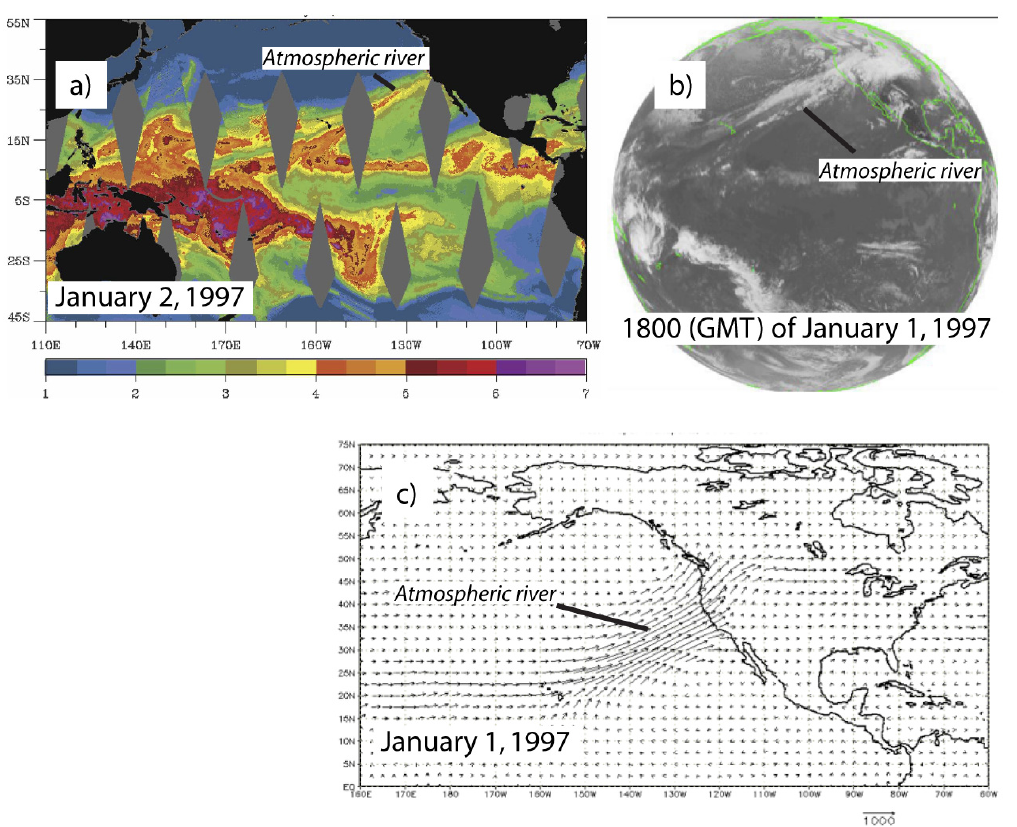
Figure 1. Visualizations of atmospheric-river conditions impacting California on 1–2 January 1997: (a) SSM/I composite satellite image of integrated water vapor (cm) on 2 January modified from figure 6 in [11]; grey diamonds represent areas not overflown by SSM/I instrument that day, (b) infrared weather-satellite imagery of the Pacific Ocean basin (GOES-West) (light colors are cloud bands, coasts indicated in green), and (c) daily-average vertically integrated water-vapor transport directions and relative rates based on NCEP-NCAR Reanalysis fields [12] describing 6-hourly historical atmospheric conditions; arrow at bottom indicates length of a 1,000 kg/m/s vapor-transport